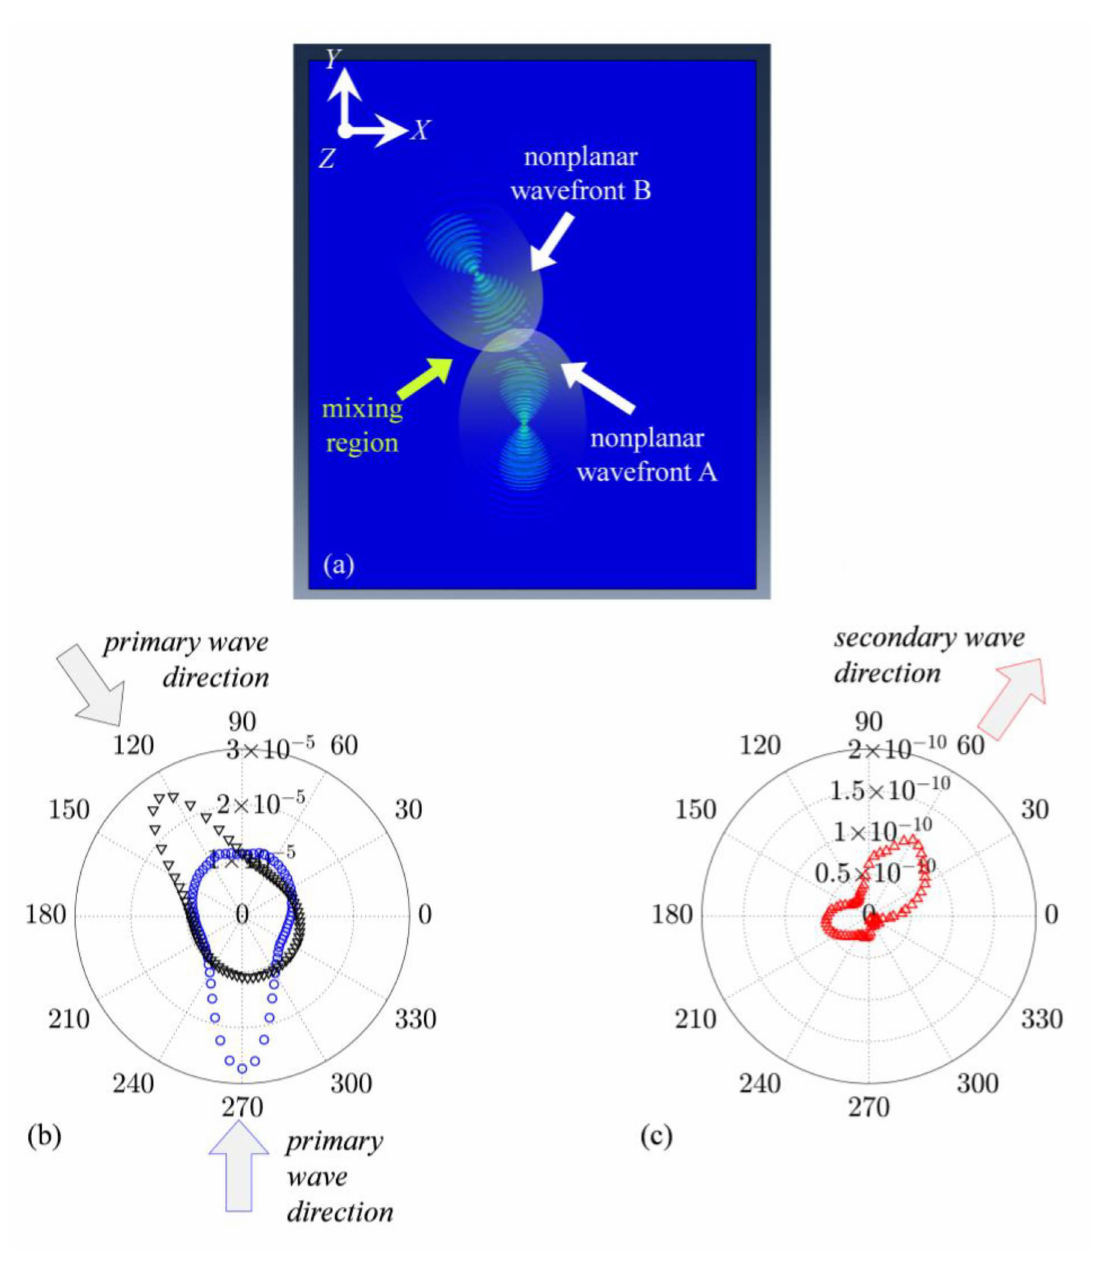
Figure 3. ( a ) Out-of-plane displacement at the top surface when A and B occur simultaneously, ( b ) amplitude of A 0 component of simulations A at f a and B at f b , ( c ) amplitude of S 0 component at f sca